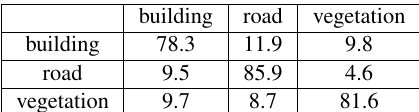
Table 1: Average pixelwise accuracy of three methods on the Bei- jing Airborne Data.